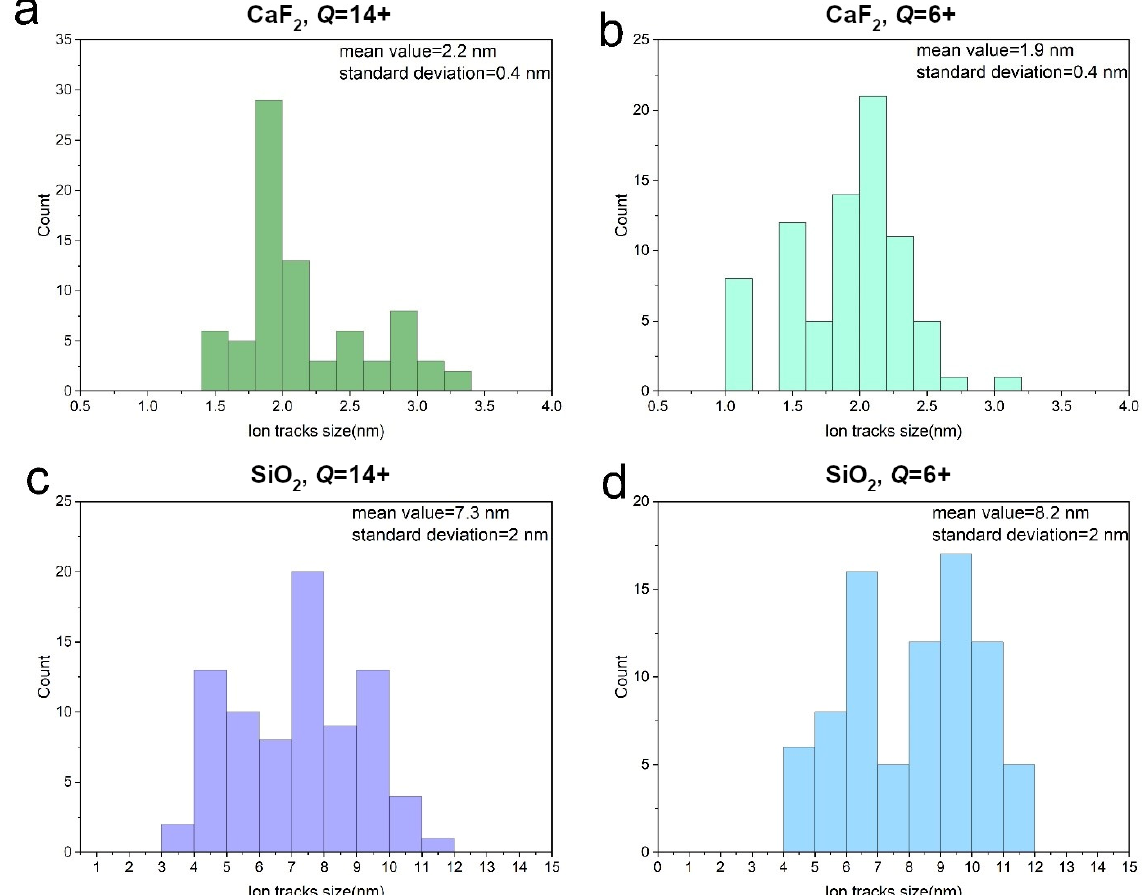
Figure 5. Distribution of the ion track diameters in CaF 2 nanocrystals irradiated with 23 MeV I at the fluence of 1 × 10 11 ions/cm 2 with ( a ) equilibrated charge state and ( b ) charge state of Q = 6+. Distribution of the ion track diameters in SiO 2 nanocrystals irradiated with 23 MeV I at the fluence of 1 × 10 11 ions/cm 2 with ( c ) equilibrated charge state and ( d ) charge state of Q = 6+.